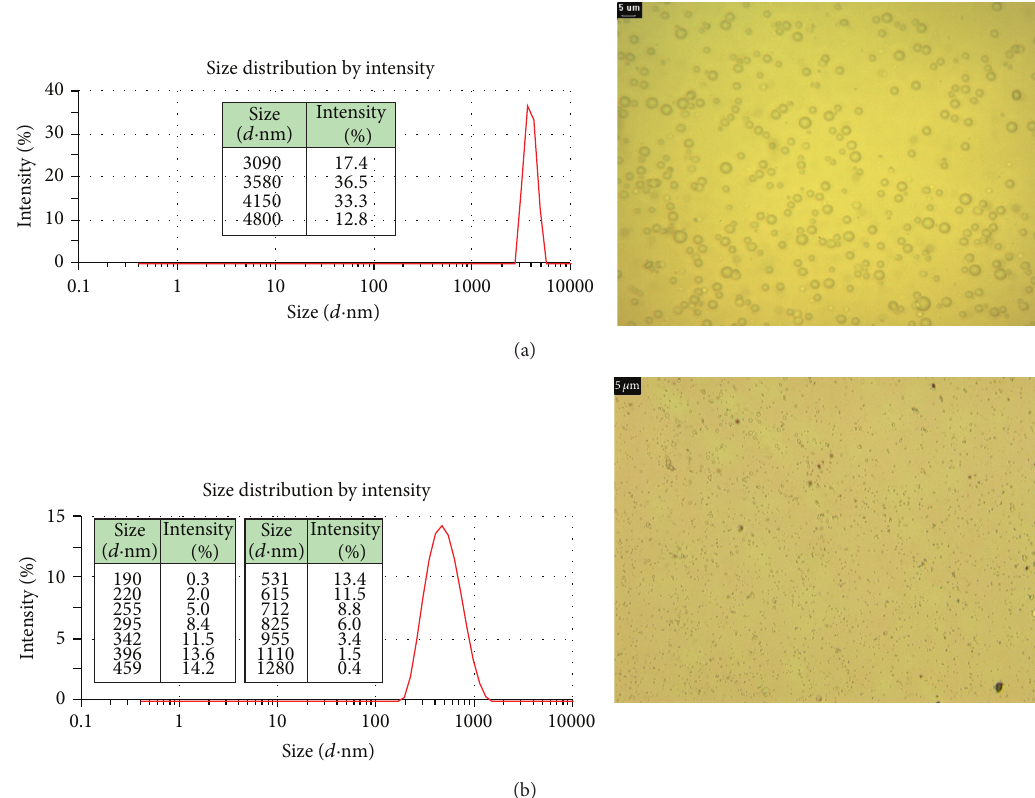
Figure 2: DLS measurements (left) and optical microscopy observation (right) of polyelectrolyte encapsulated octadecane using SDS (a) and BSA (b) as surfactants,